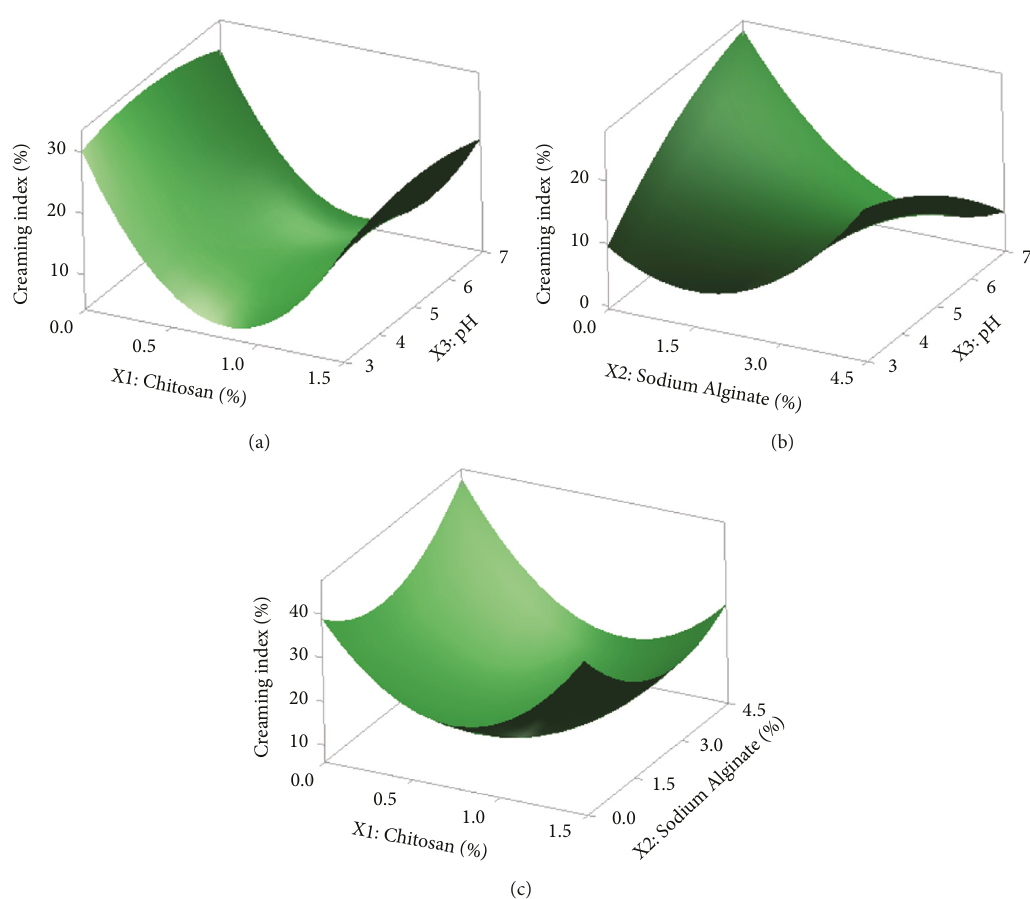
Figure 1: Three-dimensional plot of creaming of emulsion. (a) Creaming index vs. chitosan concentration. (b) Creaming vs. sodium alginate concentration. (c) Creaming vs. chitosan concentration and sodium alginate